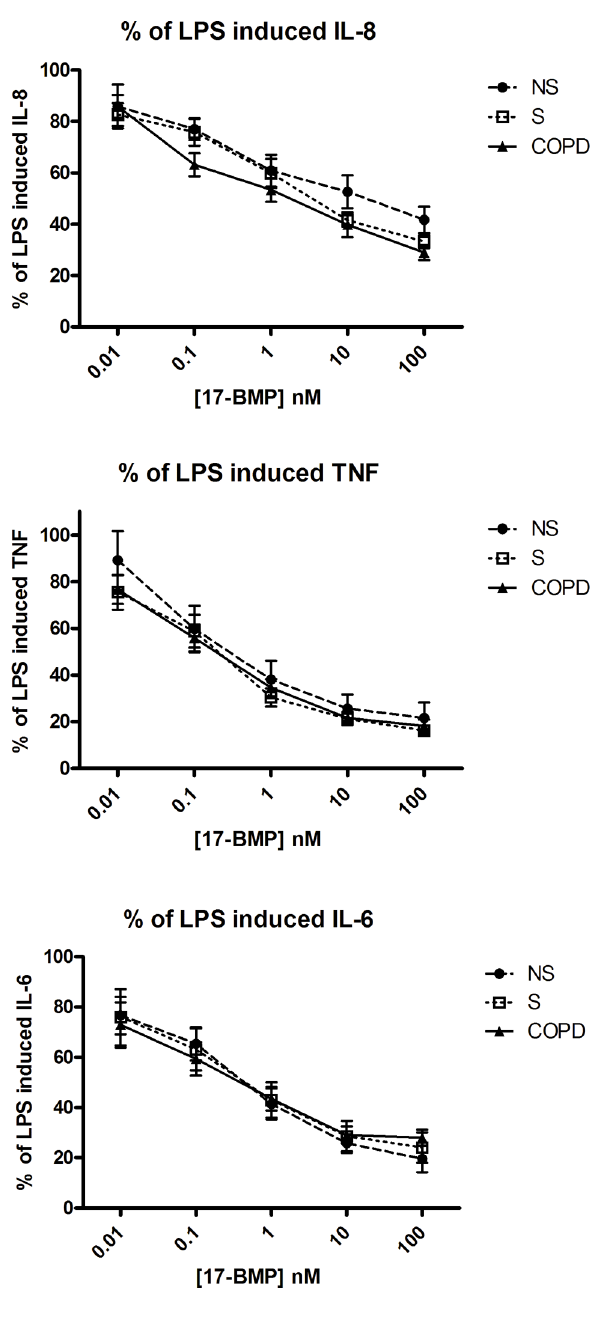
Figure 2. 17-BMP inhibition of LPS-stimulated cytokine pro- duction. Lung macrophages were stimulated for 24 hours with LPS (1 m g/ml) after a 2 h pre-incubation with 17-BMP (0.01–100 nM). Graphs plotted as a percentage of LPS effect constrained to 100%, Data shown are mean 6 SEM percentage inhibition for (A) CXCL8, (B) TNF a and (C) IL-6 ELISAs. COPD (n=25), S (n=11) and NS (n=8) shown. One-way ANOVAs were performed between groups at each concentration; there was no difference between groups at any